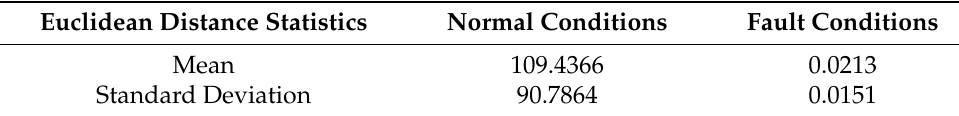
Table 6. 10 Ω fault